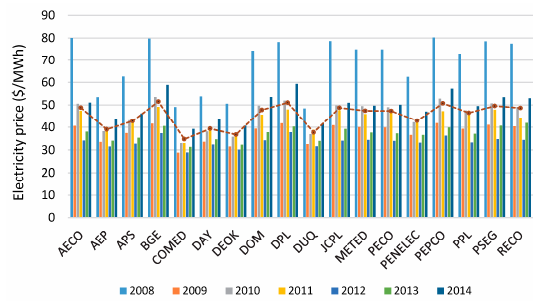
Figure 12. Yearly-based average prices of electricity in RTM across PJM zones. The dotted line represents the average per zone in the period.